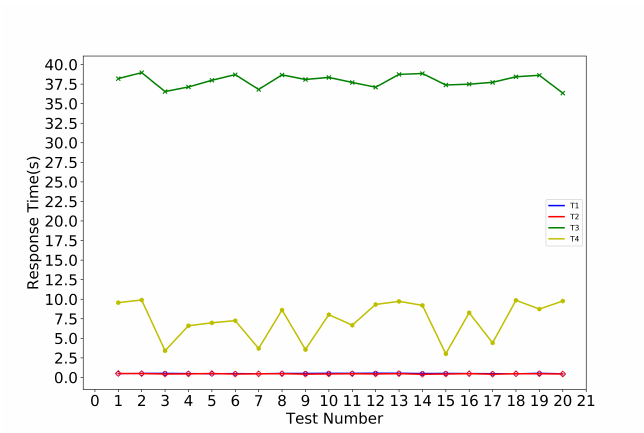
Figure 8. Results of system performance evaluation.